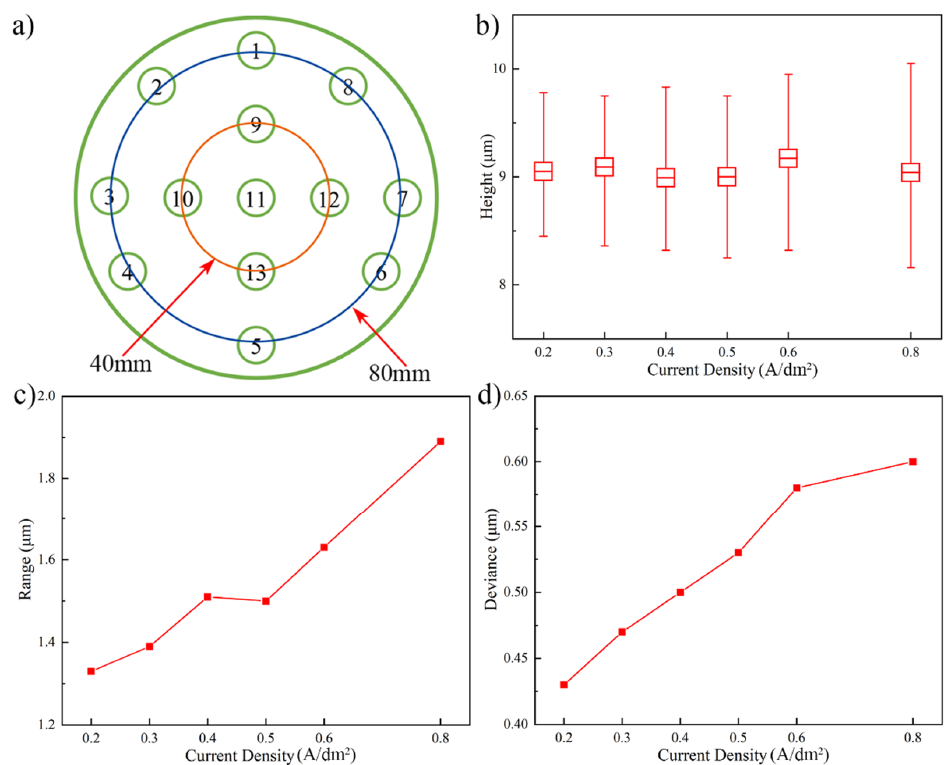
Figure 12. Influence of current density on the Au bump height uniformity in experiment. ( a ) Schematic diagram of test points distribution on the wafer, ( b ) Au bump height, ( c ) Au bump range, and ( d ) Au bump deviance.